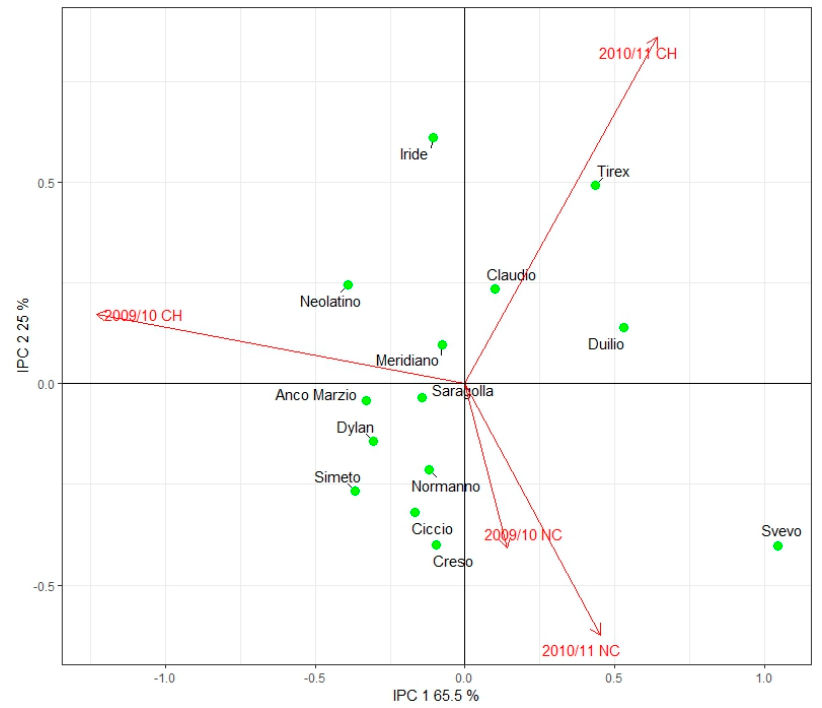
Figure 6. Biplot of IPCA1 versus IPCA2 of fourteen durum wheat genotypes under CH and NC in 2009/10 and in 2010/11 growing seasons.